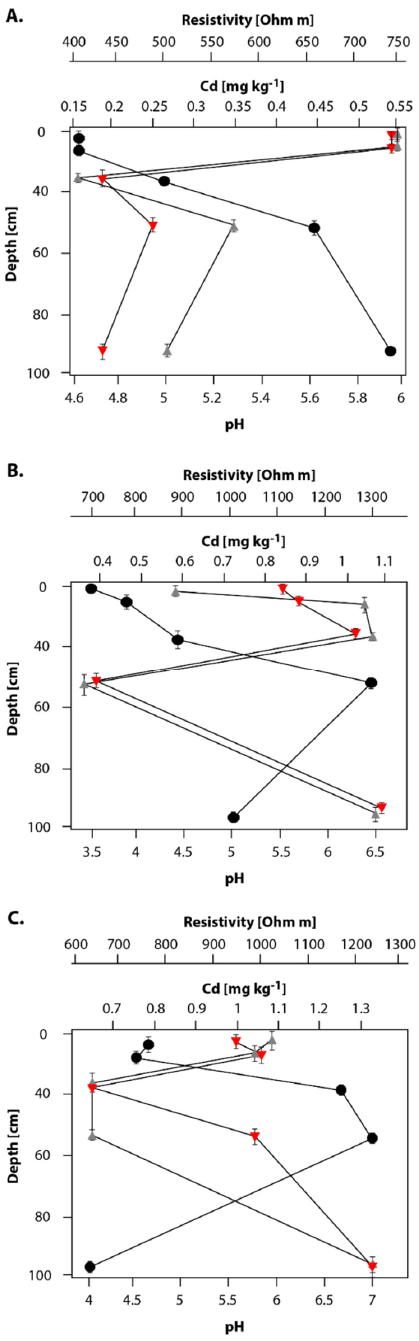
Figure 8. Vertical distribution of Cd, pH, and resistivity in soils. ( A ) Representative comparison of farms in Arauquita; ( B ) Muzo; and ( C ) San Vicente de Chucurí. In each case, the comparison shows an inverse relationship between pH (black dots), Cd (red inverted triangles), and resistivity (grey triangles), whereas a positive relationship is observed between Cd and resistivity. The values are given as mean of replicates and vertical bars represents the standard deviation ( n = 3).